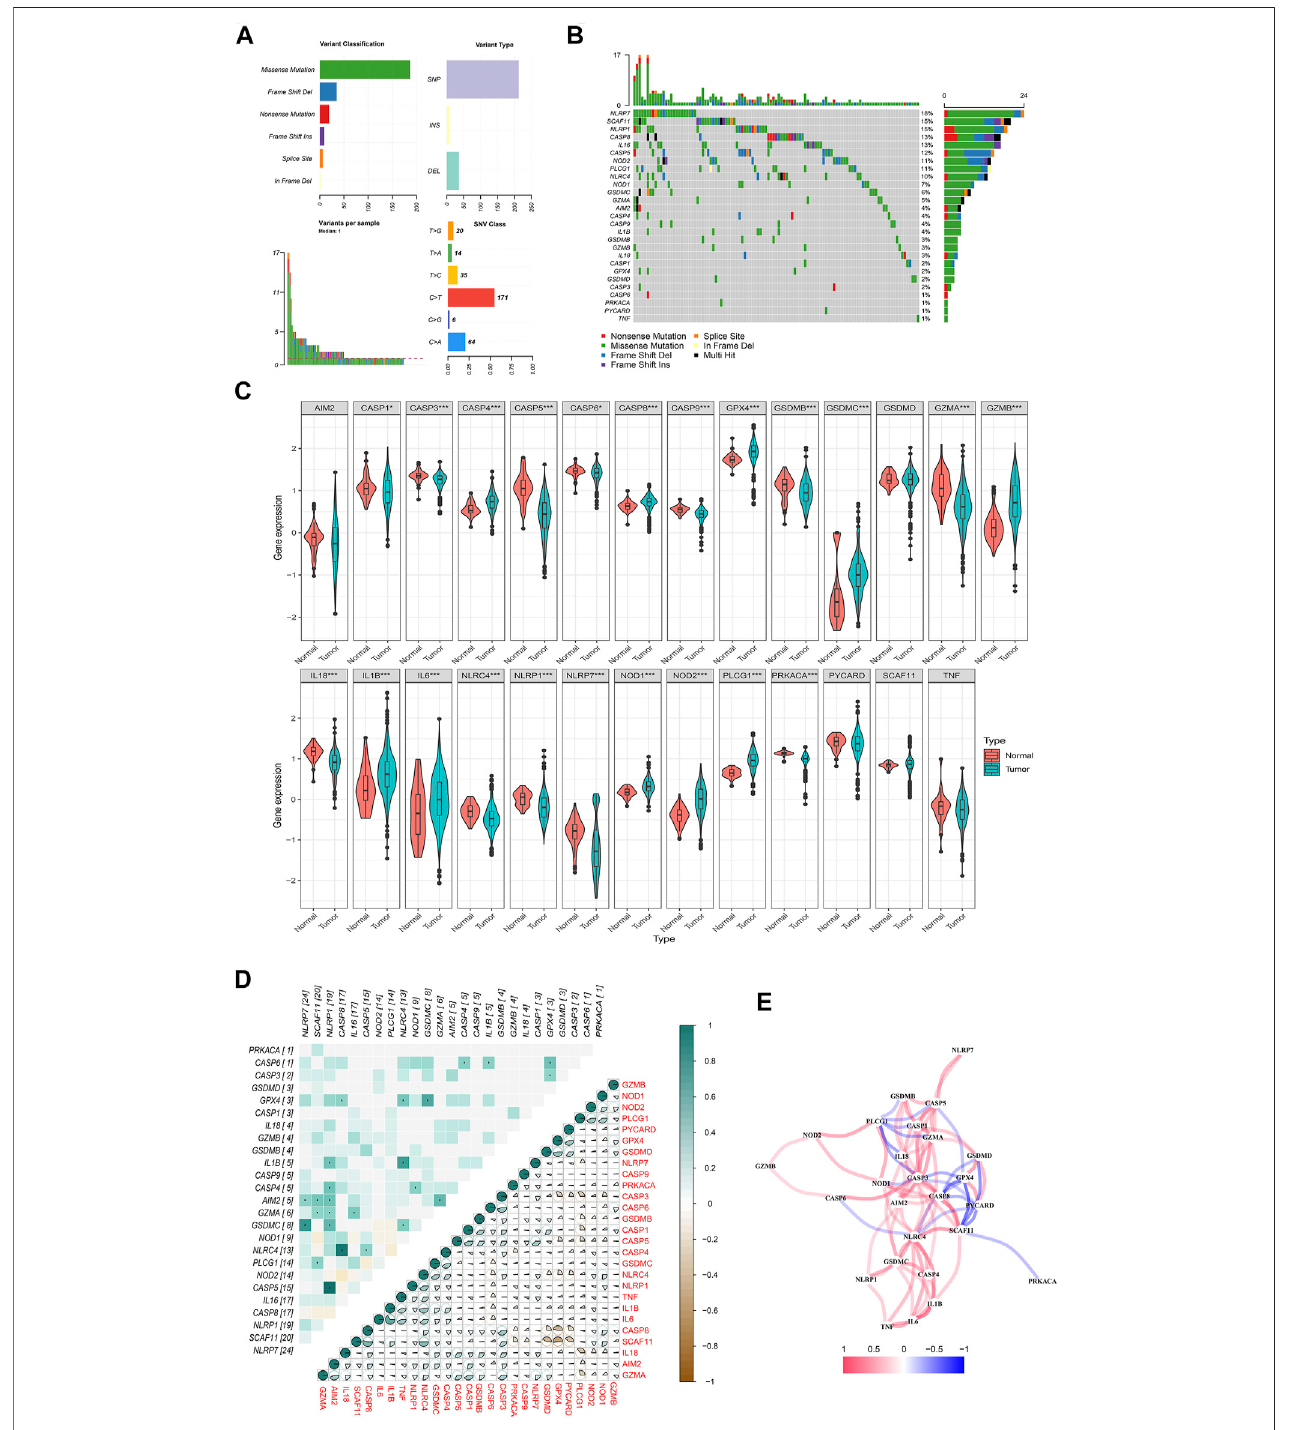
FIGURE 1 | Landscape of genetic and expression variation of pyroptosis-related regulators in colon cancer. (A, B) The mutation frequency and classi fi cation of 27 pyroptosis-related regulators in colon cancer based on The Cancer Genome Atlas — Colon Adenocarcinoma (TCGA-COAD). (C) The expression of 27 pyroptosis- related regulators in colon cancer and normal tissues: tumor, blue; and normal, red. The upper and lower ends of the boxes represent the interquartile range of values. The lines in the boxes represent median value, and black dots show the outliers. The asterisks represent the statistical p -value. Mann – Whitney U test. * p < 0.05; ** p < 0.01; *** p < 0.001; p ≥ 0.05, not signi fi cant. (D) Heatmap showing the correlation of genetic variation and expression variations of pyroptosis-related regulators. Left: genetic variation; right: expression variations. p < 0.05. (E) The correlation network of the pyroptosis-related genes (red line, positive correlation; blue line, negative correlation; the depth of the colors re fl ects the strength of the